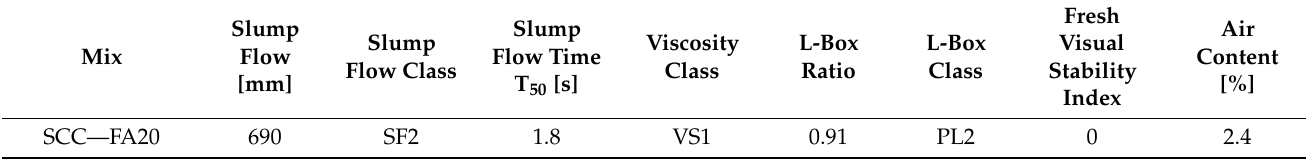
Table 3. Fresh properties test